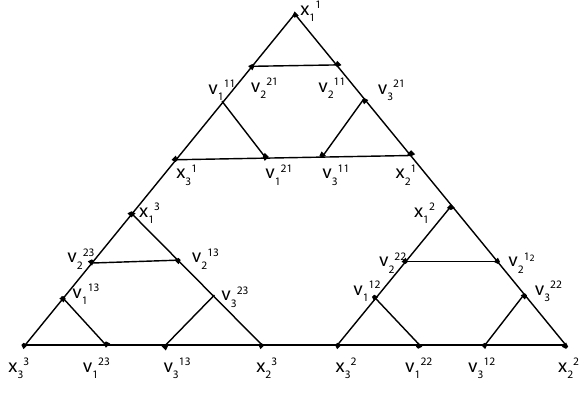
Figure 2. A C 3 -based Sierpinski Network with n = 3, S ( 3, C 3 )